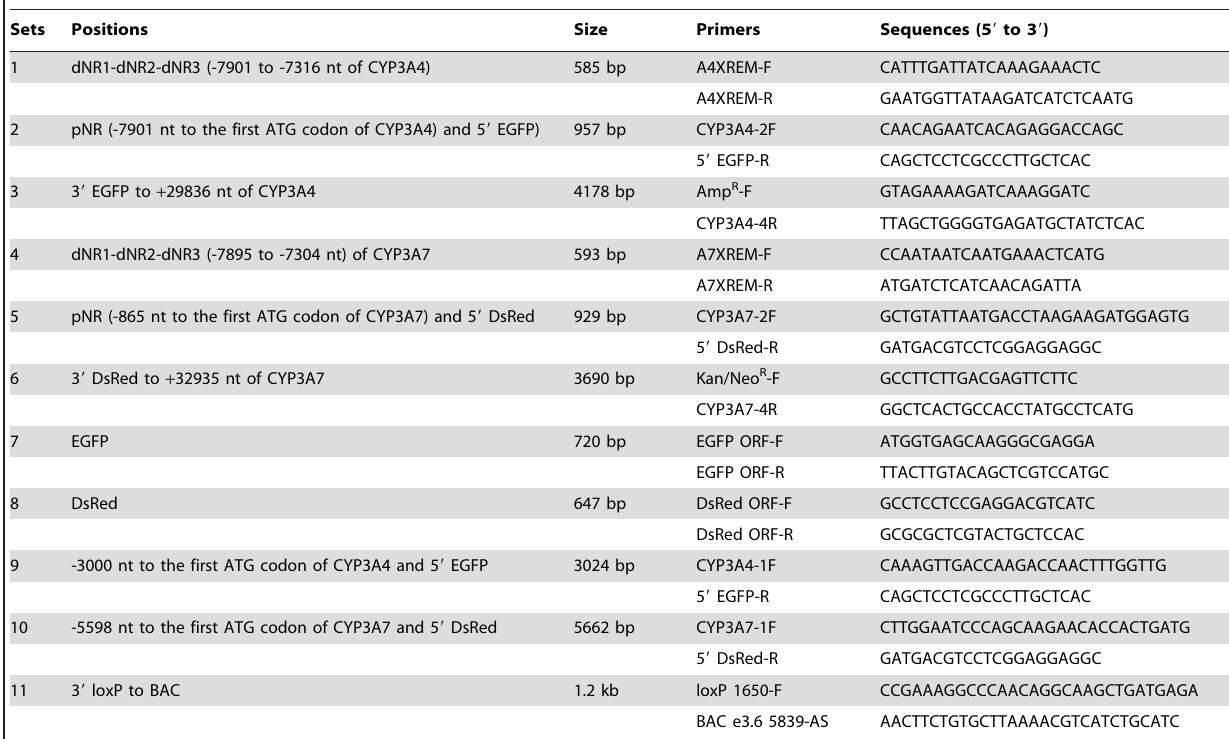
Table 1. PCR primers used for genomic RCR analyses.